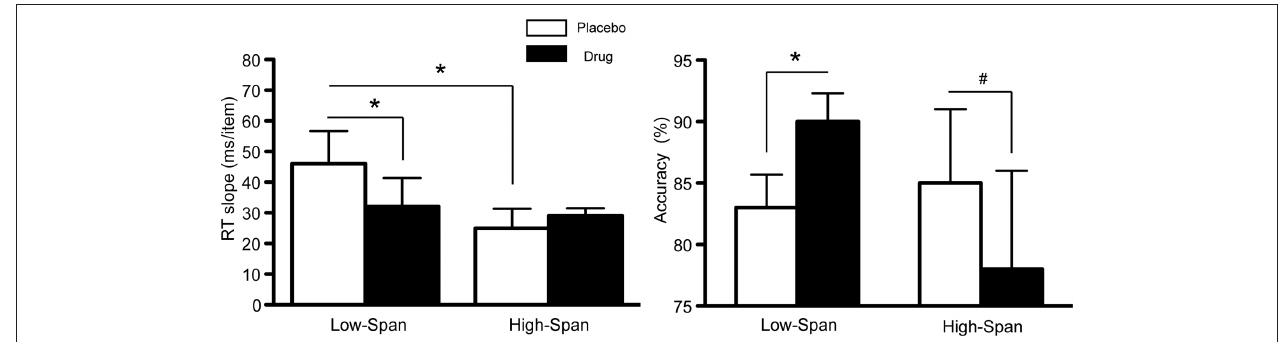
FIguRe 1 | The effect of bromocriptine on RT slope and accuracy on high-load trials on a delayed recognition task is dependent on working memory span. Data shown represents mean ± SE of the mean. Asterisks indicate p < 0.05; # indicate p